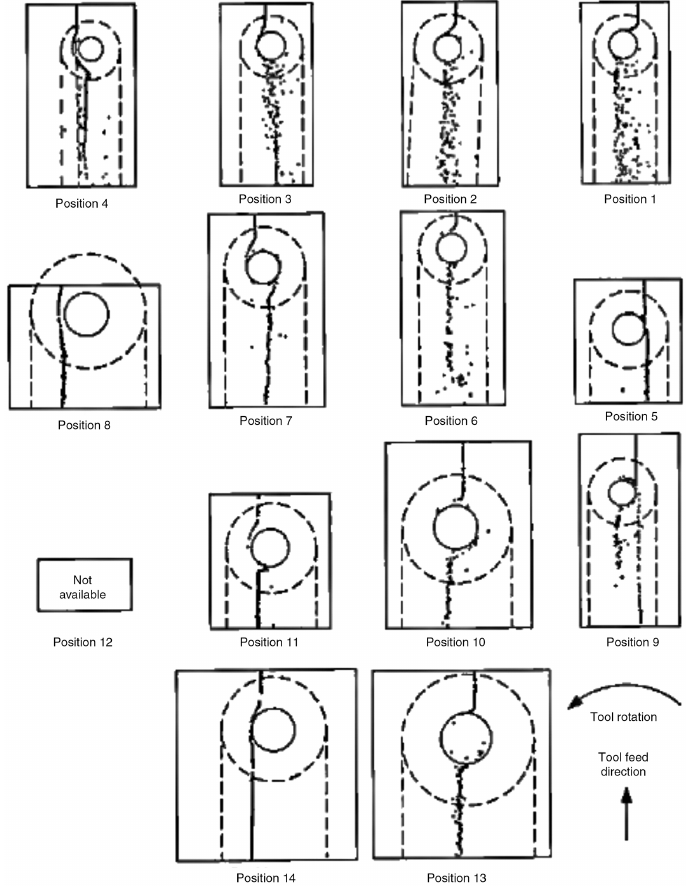
Figure 8: Drawings generated from each of the plan view radiographs for the 7075 welds are shown here. The positions are defined relative to the welding tool dimensions in Figure 6.